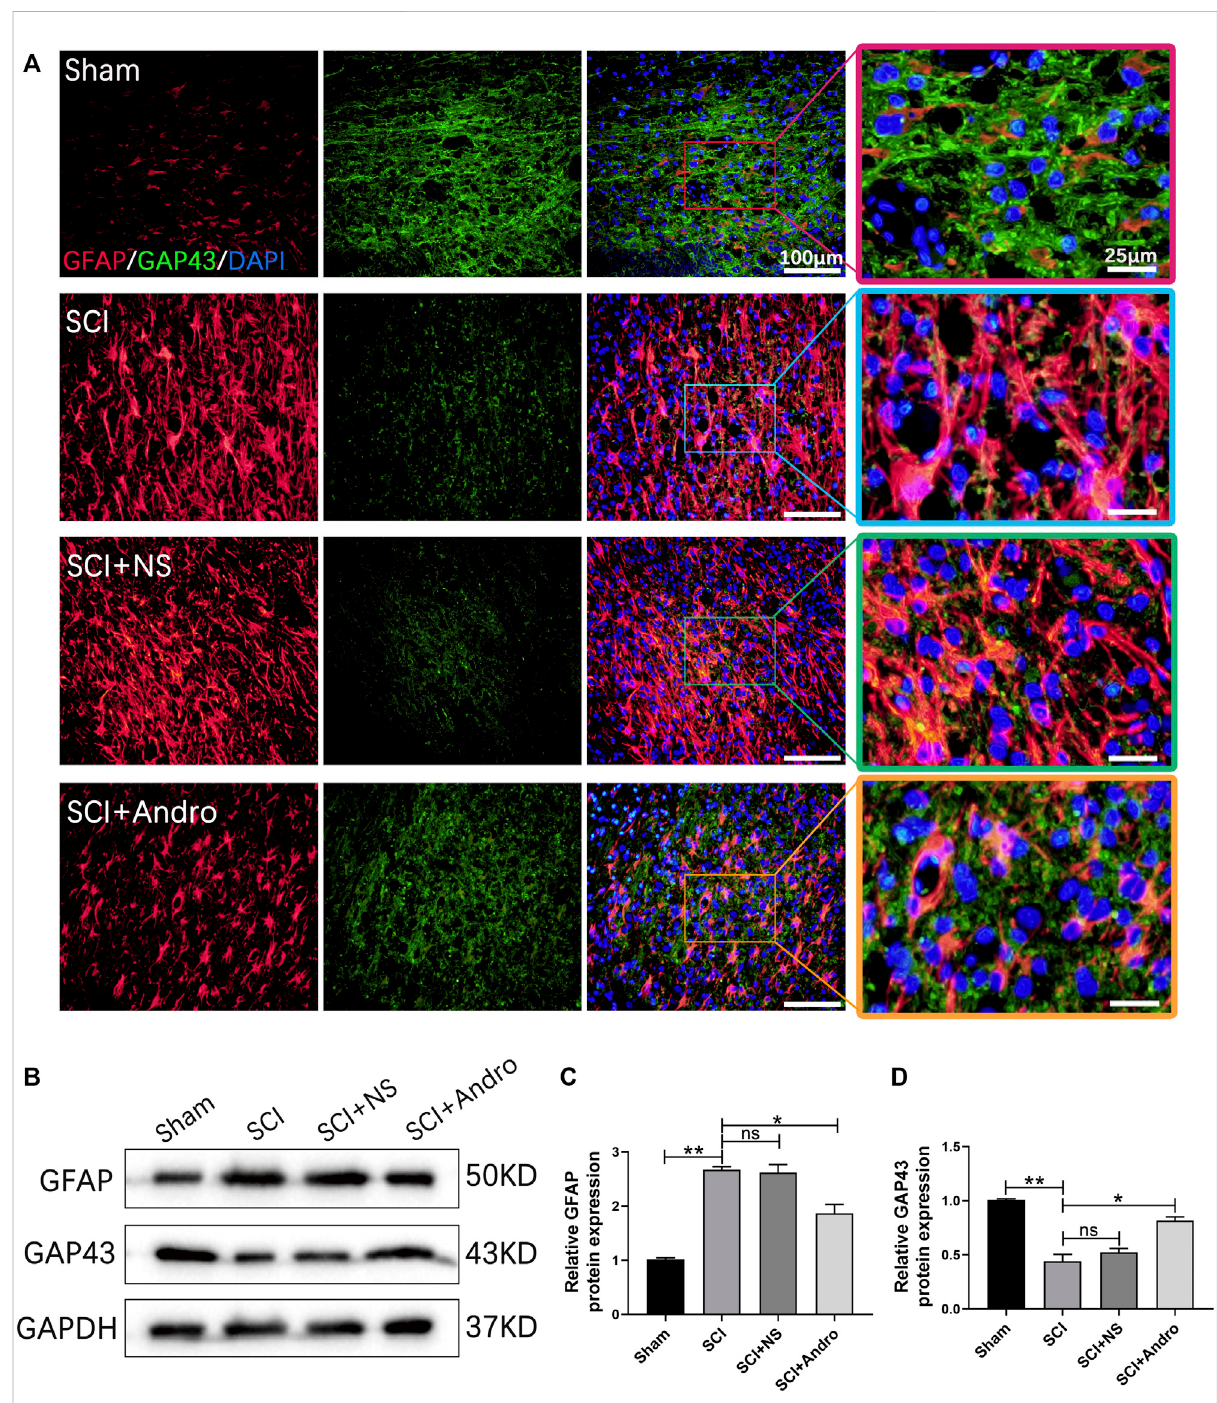
FIGURE 5 Andro treatment promoted axonal regeneration of SCI rats. (A) Co-immuno fl uorescent staining showing the glial scar (GFAP, red) and the axonal regeneration (GAP43,green) in spinal cord tissues 28 days post-SCI. (B – D) Immunoblot and relative quanti fi cation of GFAP and GAP43 proteins. Data are presented as the mean ± SD, n = 3 per group.* p < 0.05,** p < 0.01, ns p ＞